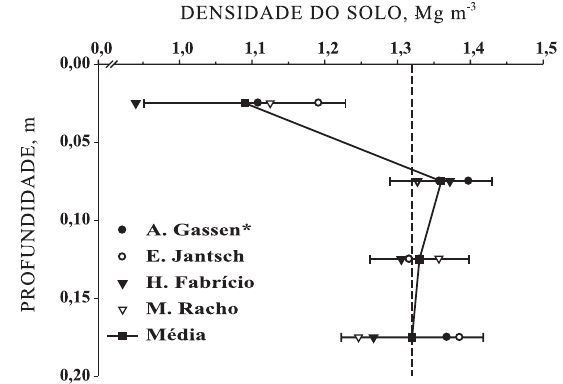
Figura 1. Densidade de um Latossolo Vermelho distroférrico nas quatro áreas experimentais por ocasião da implantação do experimento em Santa Rosa, RS. * A identificação das áreas foi baseada no nome de seus proprietários. As barras horizontais representam o desvio-padrão da média. A linha vertical indica a densidade restritiva ao crescimento de raízes proposto por Suzuki et al. (2006), para solos com 640 g kg -1 de